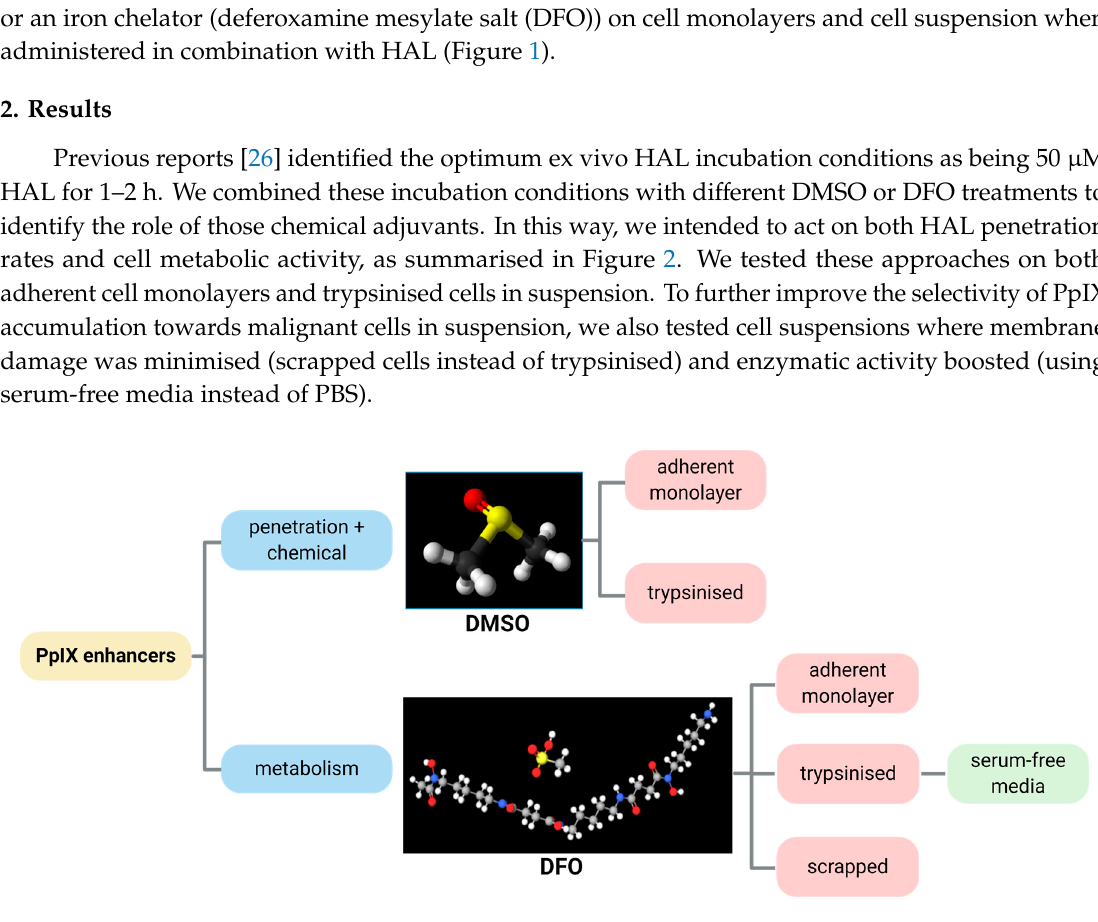
Figure 1. Schematic diagram of the heme biosynthesis pathway (left) and the principle of HAL mediated PpIX production enhancement with dimethylsulphoxide (DMSO) or deferoxamine mesylate salt (DFO) (right). DMSO favours the formation of pores in the cell and mitochondrion membranes, which increase the uptake of hexaminolevulinate 5-aminolevulinic acid (HAL (5-ALA)) and in turn boosts intracellular protoporphyrin IX (PpIX) synthesis (green arrow). In contrast, DFO inhibits the conversion of PpIX to heme by chelating iron (red arrow). The administration of both prodrugs attempts to enhance PpIX accumulation. The number [1 to 4] corresponds to the factors why preferentially accumulates in cancer cells when compared with normal cells.